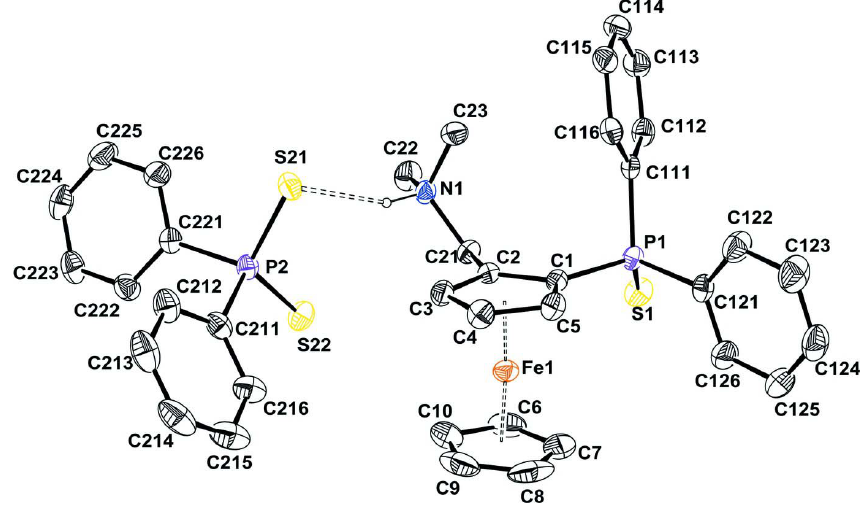
The asymmetric unit of (I) with the atom-labelling scheme. Displacement ellipsoids are drawn at the 50% probability level. H atom is represented as small sphere of arbitrary radii. Hydrogen bond is shown as dashed lines. H atoms not involved in hydrogen bondings within the Figure have been omitted for